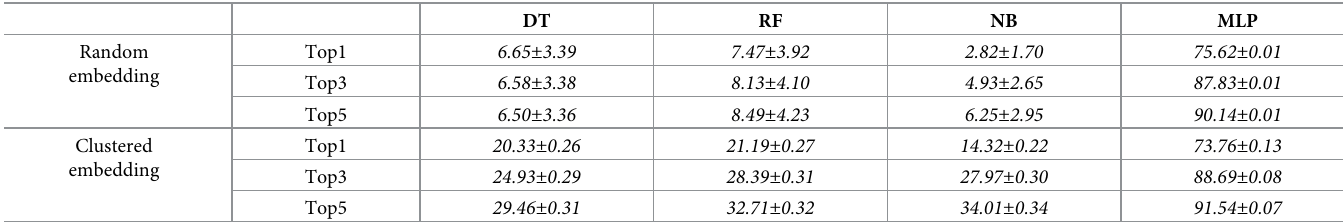
Table 6. The results of random and clustered embedding methods with various